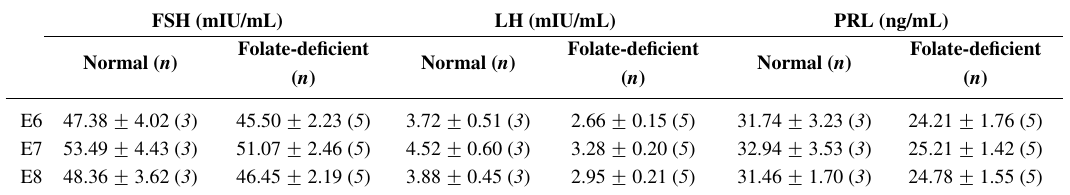
FSH, follicle stimulating hormone; LH, luteinizing hormone; PRL, prolactin.